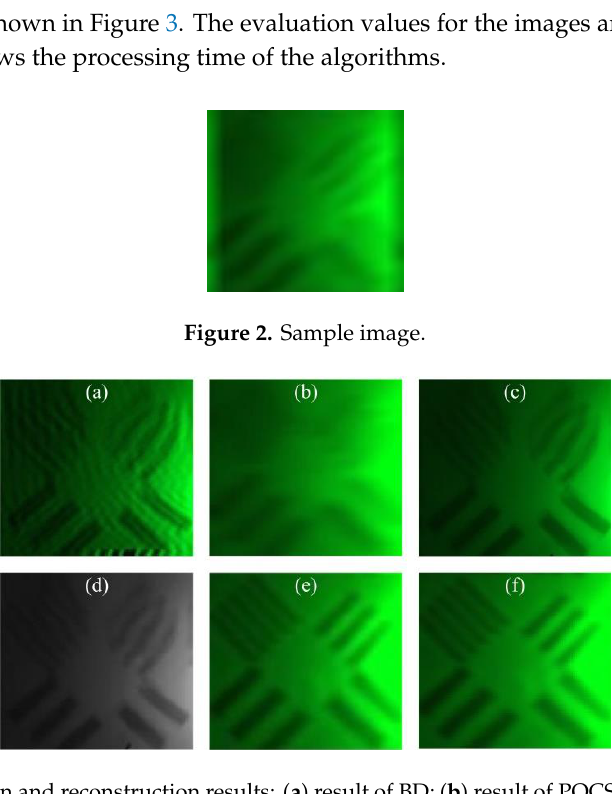
Figure 3. Restoration and reconstruction results: ( a ) result of BD; ( b ) result of POCS; ( c ) result of M − SB; ( d ) result of M − TV; ( e ) result of PIV − RR; ( f ) result of the proposed method in this paper. Table 1. Comparison of evaluation results.